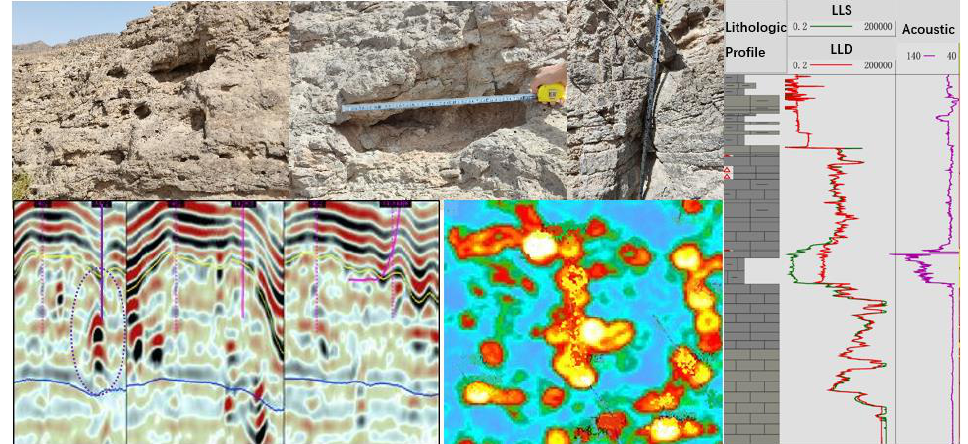
Figure 15. Geology and geophysics response of fractured karstic carbonate rocks.